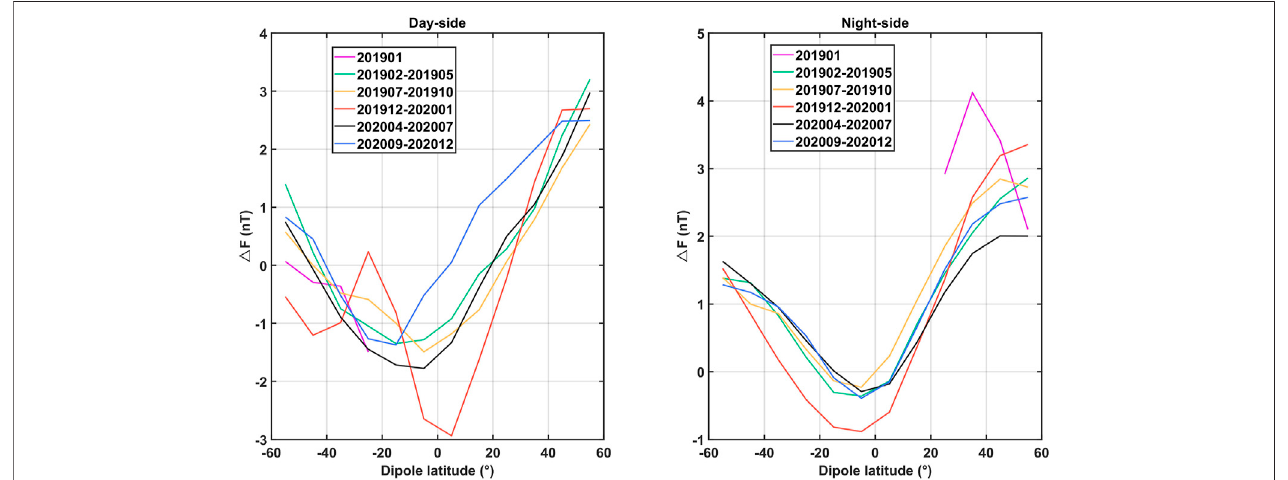
FIGURE 13 | Results of subtraction using the mean values of the CDSM and ASM Δ F in different periods.